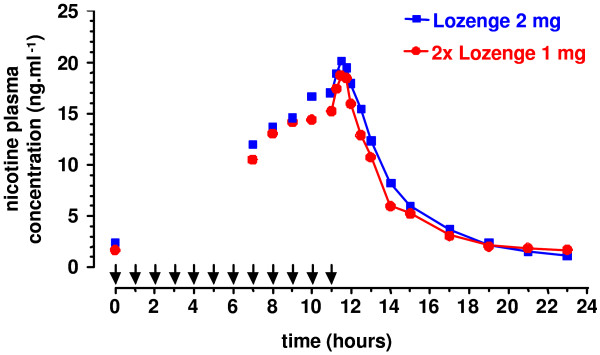
Dose proportionality of nicotine lozenges with respect to nicotine plasma concentrations (31 subjects). Nicotine plasma concentrations were determined from blood samples of 31 volunteers drawn before hourly administration 1 or 2 mg nicotine lozenge (unconnected data points). Consecutive blood samples (connected data points) were drawn after administration of dose 12 (t = 11 h), and the derived data points are connected. Plasma concentrations obtained with 1 mg lozenges were doubled for ease of comparison.